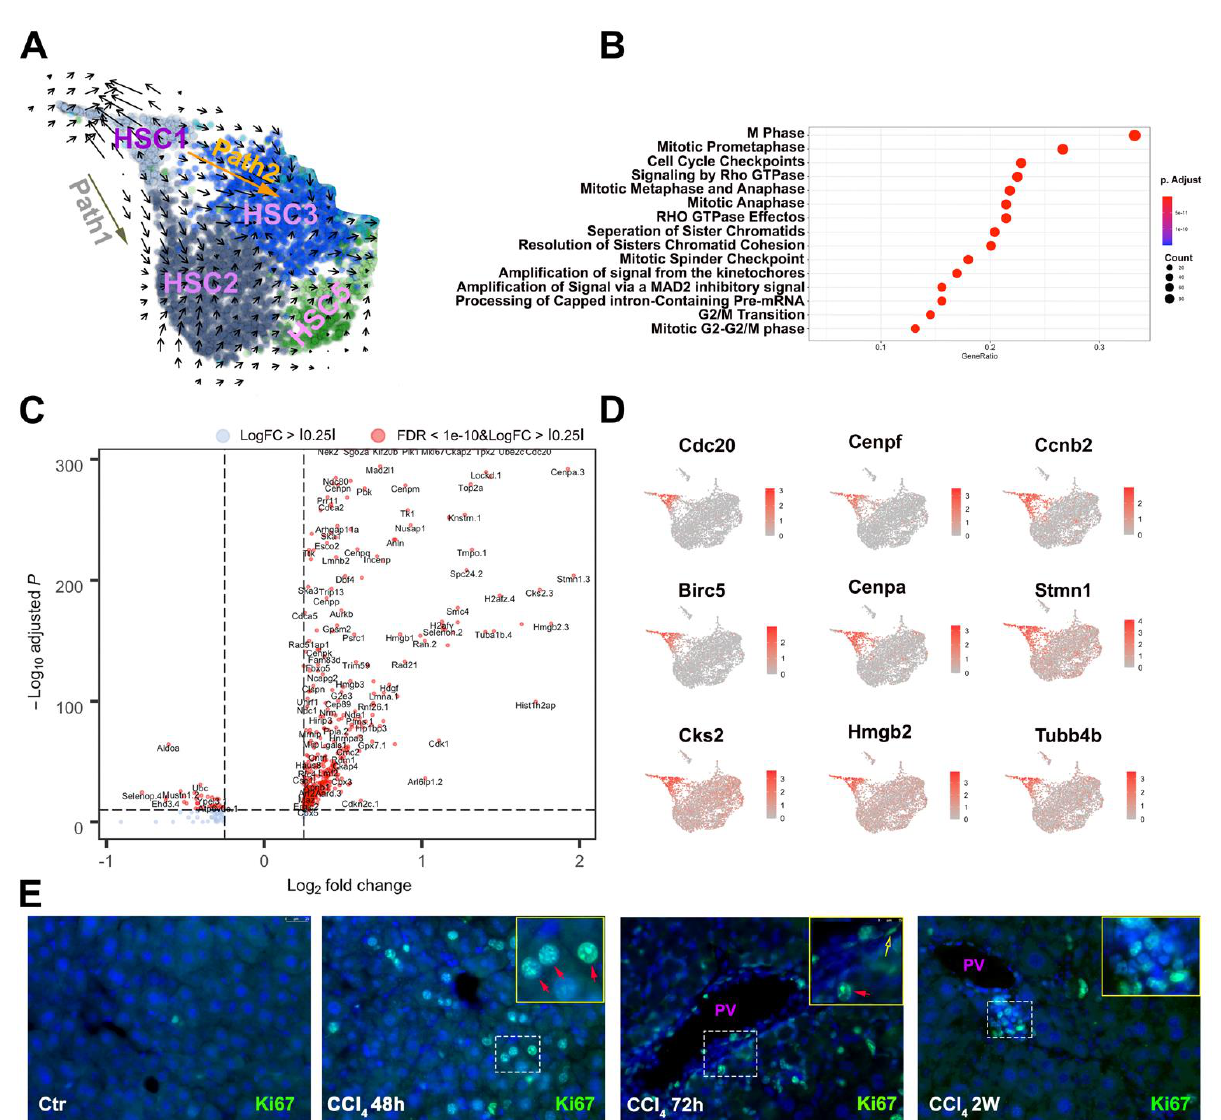
Figure 3. HSC1 as an early activated HSC subtype in response to CCl 4 treatment. ( A ) scRNA velocity analysis overlaid on UMAP plot suggested the trajectory path from HSC1 to HSC2 and HSC3. ( B ) and ( C ), Reactome pathway analysis and volcano plot demonstrated, respectively, the activation of the pathways related to cytokinesis and the upregulation of the genes associated with cell proliferation. ( D ) Representative Loupe images of genes involved in cytokinesis in HSC1. ( E ) Representative images of Ki67 immunofluorescent staining of mouse livers isolated from CCl 4 -treat mice at indicated times (200×). Red arrows indicated the Ki67 staining positive hepatocytes; Yellow arrows indicated the Ki67 staining positive non-parenchymal cells.